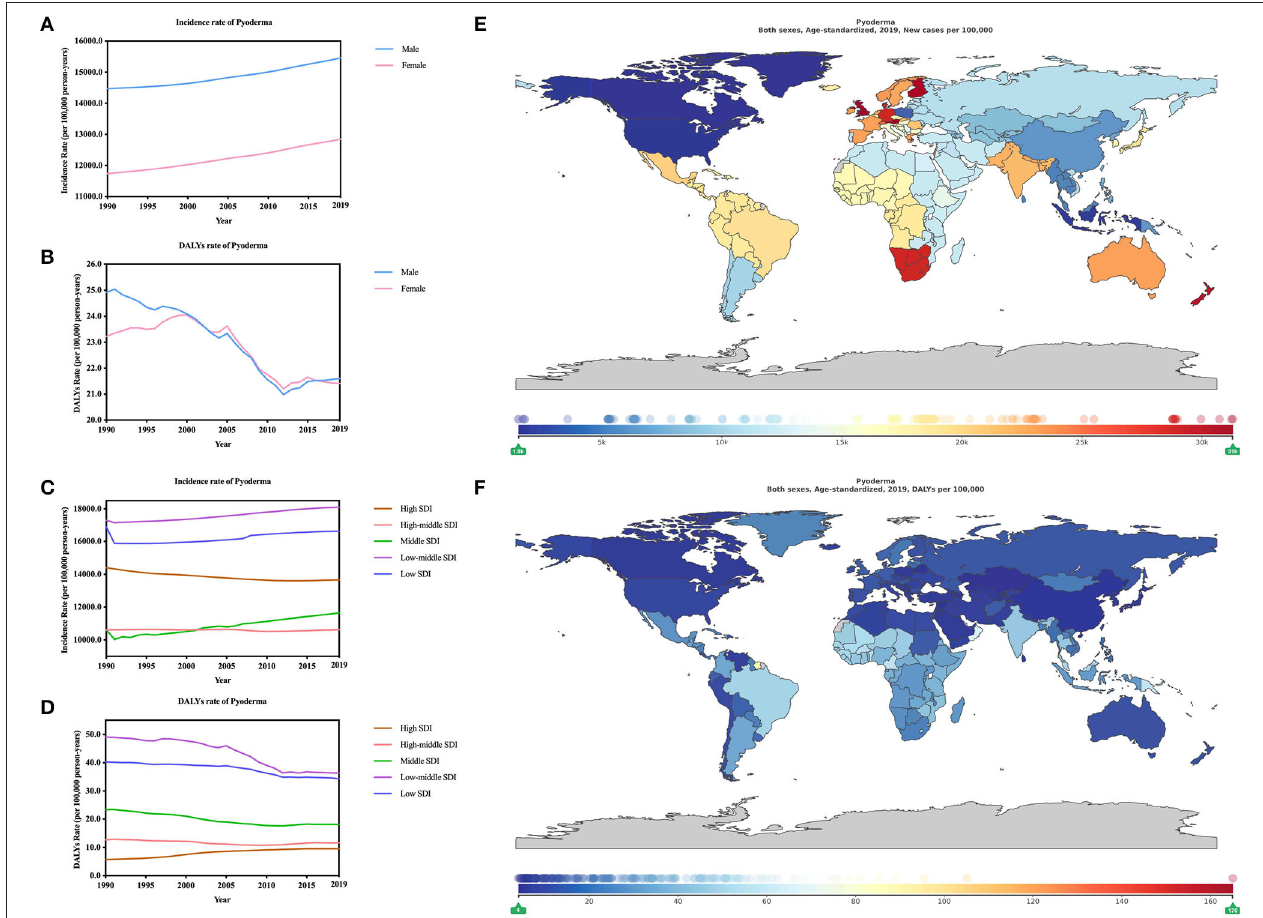
FIGURE 3 | Burden of pyoderma for 204 countries and territories. Age-standardized incidence and DALYs rates of pyoderma (A,B) by sex; (C,D) , by SDI per 100,000 population globally,1990–2019. The distribution of age-standardized incidence (E) and DALYs (F) rates of pyoderma per 100,000 population globally, in 2019.